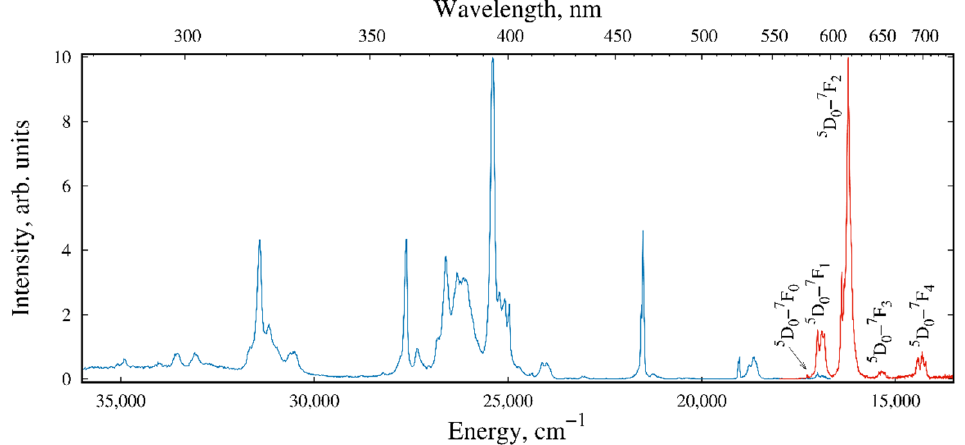
Figure 2. Excitation (blue line, λ em = 616 nm) and emission (red line, λ ex = 394 nm) spectra of 2 (solid sample, RT).